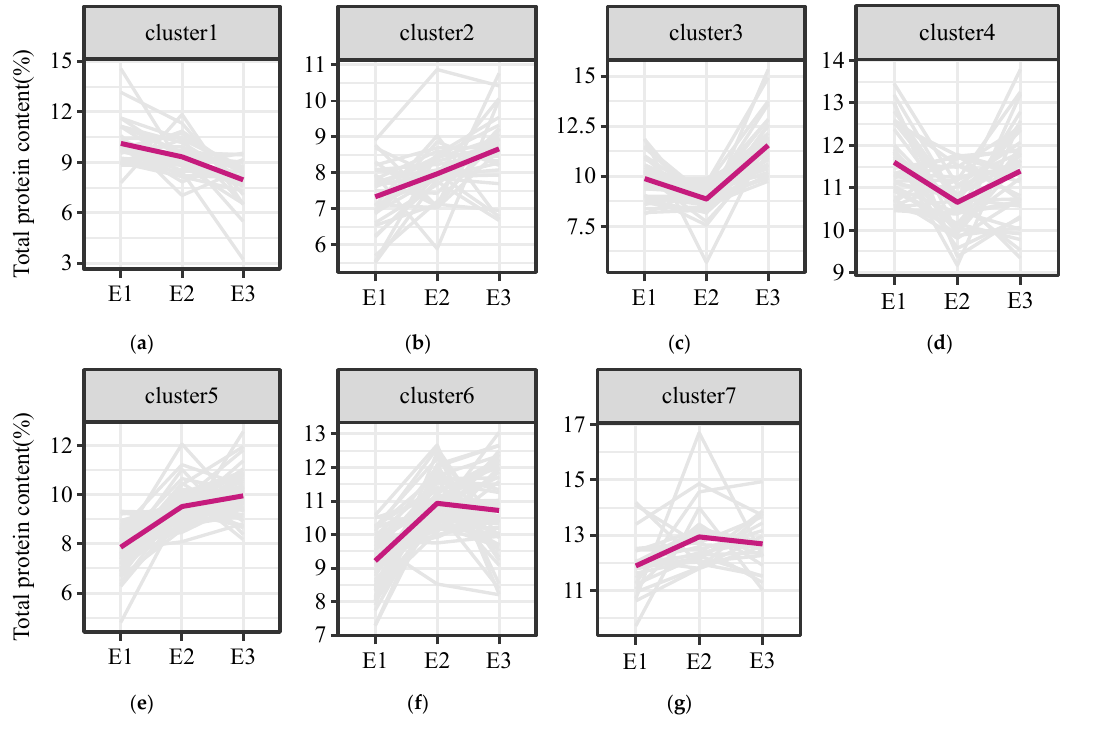
Figure 2. Distribution trend of TPC of foxtail millet in seven clusters ( a – g ) under three environments. K ‐ means clustering analysis was performed in 295 accessions of foxtail millet under three environments. The accessions were grouped into 7 clusters with different trends of TPC in E1, E2, and E3. To further investigate the effect of individual climate factors on the TPC, the correla ‐ tion relationships between TPC and ATG, AAT, MDTRG, MDTR, TRF, DASSH, and ALT were analyzed (Figure 3). The results revealed that the TPC of 61 accessions in cluster 5 was positively correlated with ATG ( p < 0.05) and MDTGR ( p < 0.001) but significantly negatively correlated with MDTR ( p < 0.01). The TPC of 88 accessions in clusters 6 and 7 was significantly positively correlated with AAT ( p < 0.05, p < 0.01), and the TPC of 32 accessions in cluster 1 showed a significant positive correlation with DASSH ( p < 0.01); however, the TPC of the remaining groups did not show any correlation with any of these climate factors.